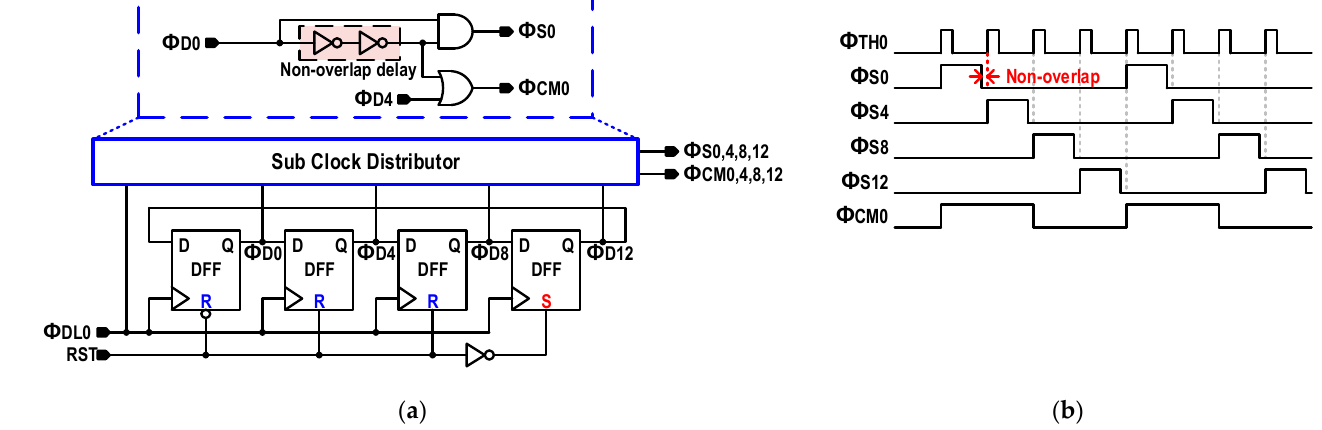
Figure 11. Sub clock generation for 4-channel sub-ADCs. ( a ) A 1.25 GHz 4-phase clock generator. ( b ) Timing diagram.